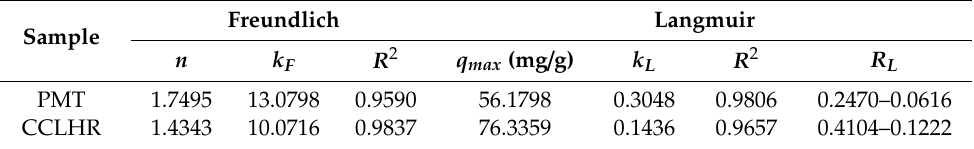
Figure 7. Langmuir isothermal adsorption equation fitting of methylene blue: ( a ) PMT, ( b ) CCLHR. Table 2. Adsorption isotherm parameters for methylylene blue